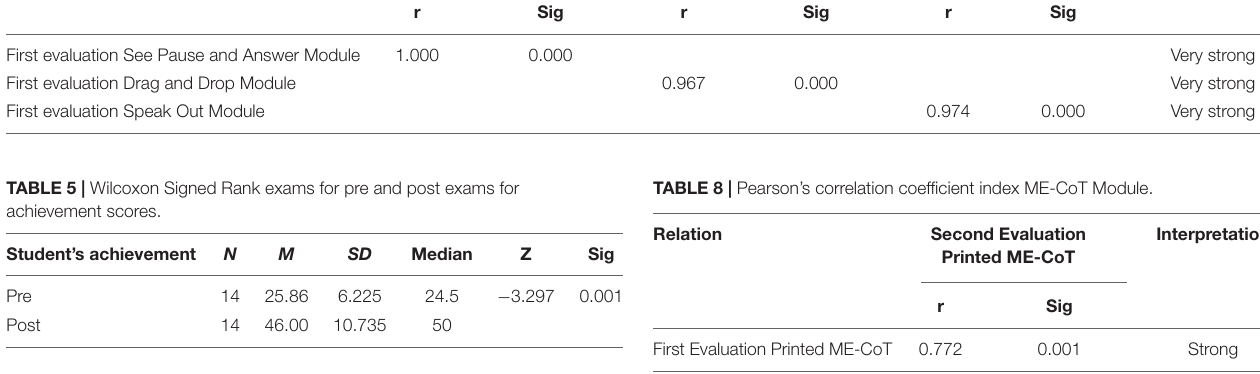
TABLE 6 | Pearson’s correlation coefficient index r Computational Thinking as a problem solving. Relation